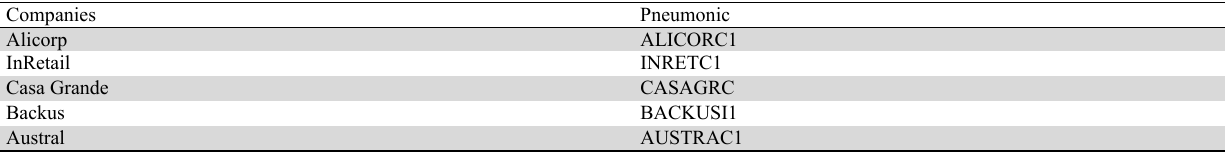
Companies in the consumer sector S&P/BVL Peru Select